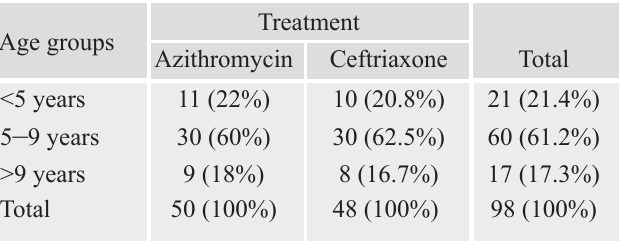
Table I: Age distribution of study subjects Age groups